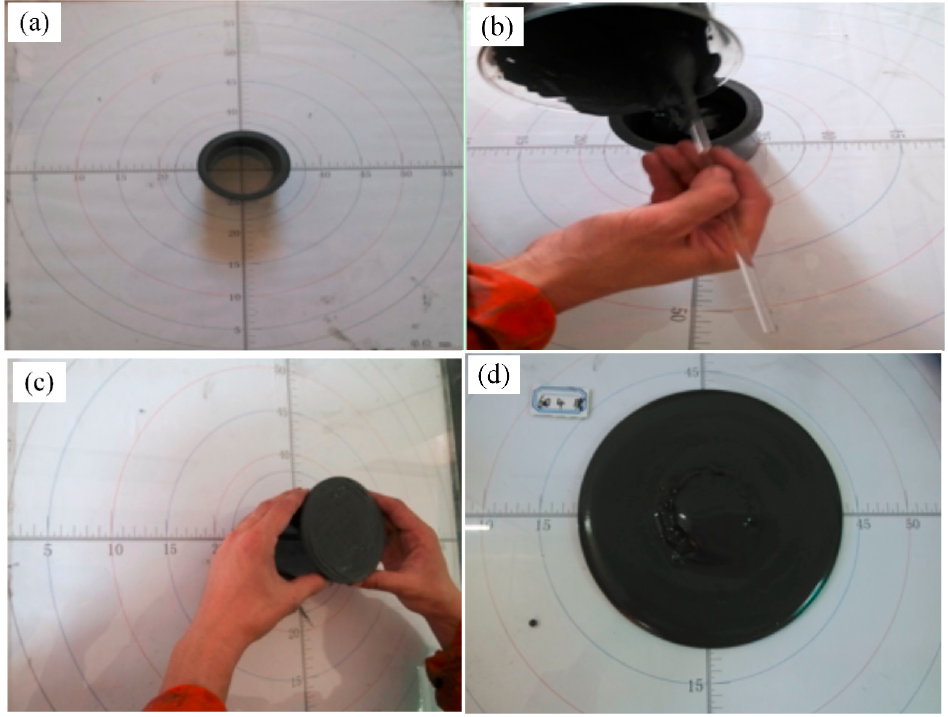
Figure 3. Diffusivity test of the slurry: ( a ) mould; ( b ) grouting; ( c ) release and ( d ) measure.